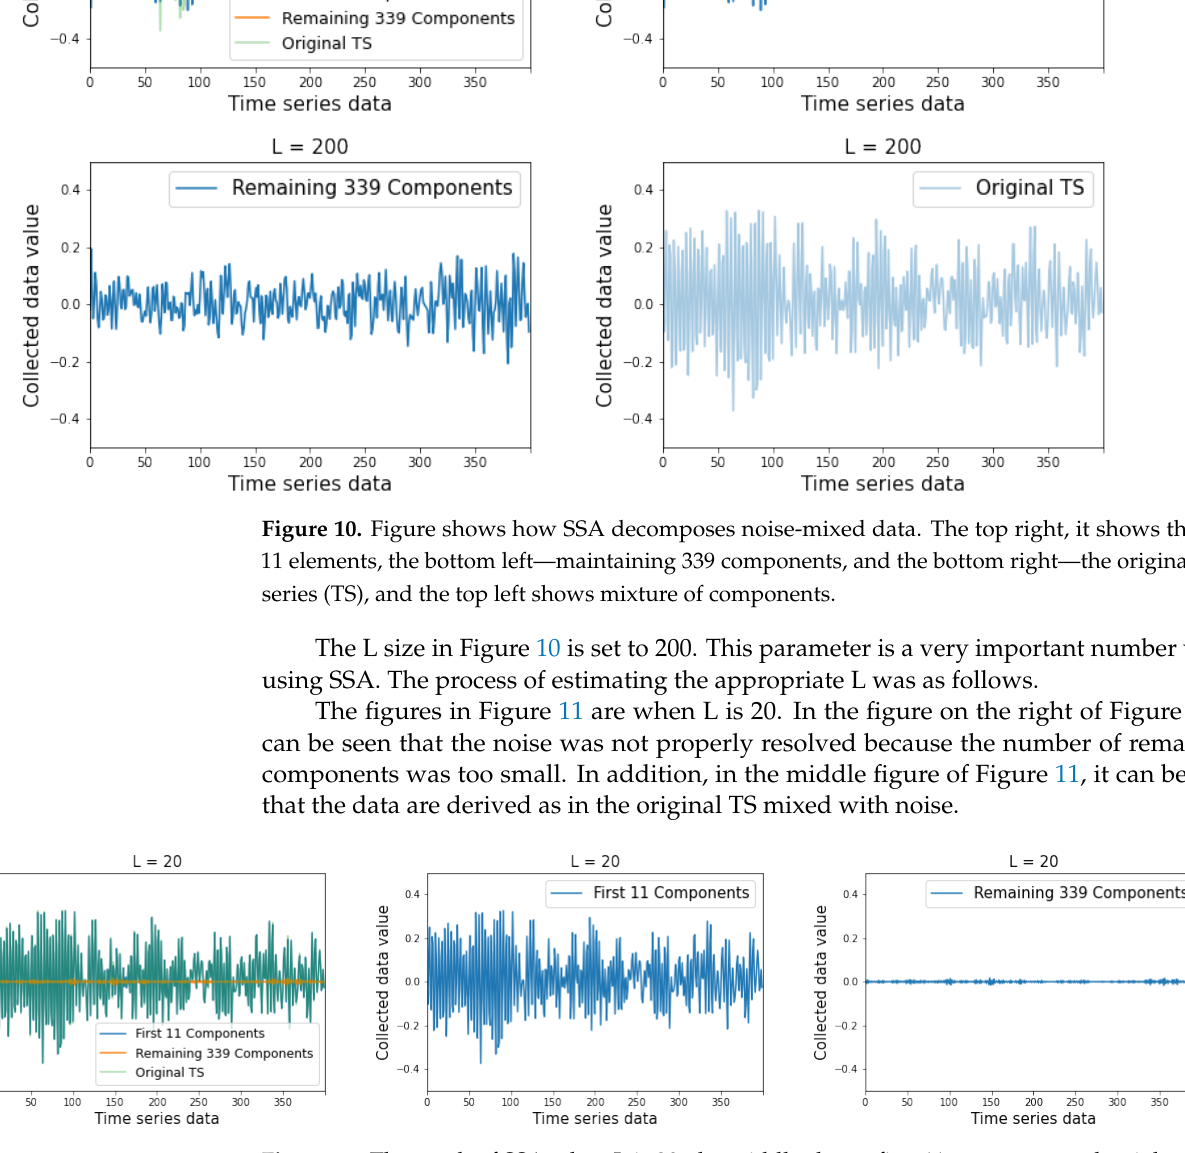
Figure 11. The result of SSA when L is 20, the middle shows first 11 components, the right shows remaining 339 components, the left shows mixture of